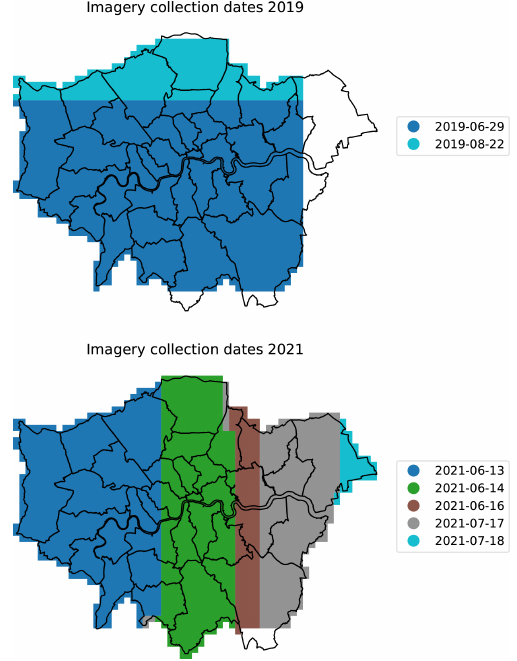
Figure 2. Collection dates for the aerial imagery mosaic covering Greater London. The primary imagery dataset used was that from 2021, while the 2019 data were used for comparison. Table 3. Classification performance metrics calculated in this